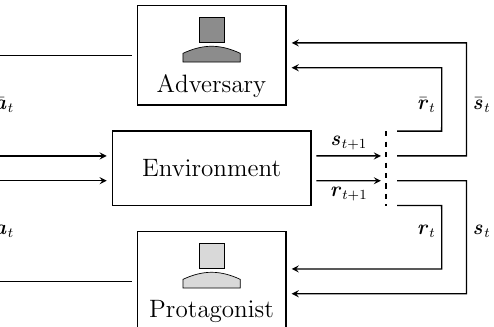
Figure 4. Schematic representation of the two-player zero-sum Markov game. Transitions are depicted in a discrete-time formulation to define variables at every time step. Each state is composed of a vector of observations or sensory inputs of the agents. The agents can choose an action from their respective action spaces evaluated through a reward function at every step. For the specific r t two-player zero-sum case as depicted here, ¯ r t = −